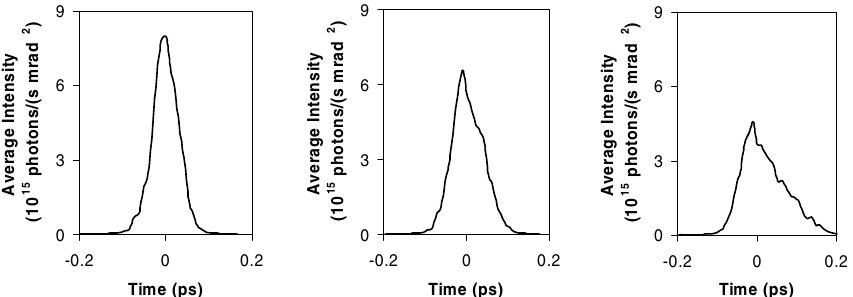
FIG. 15. Simulation of pulse slicing by Bragg reflection showing the spatially averaged intensity vs time for the case of radial collimation widths of 0.1 mrad (left panel), 0.25 mrad (middle panel), and 0.5 mrad (right panel), corresponding to FWHM pulse durations of 70, 80, and 100 fs, respectively, and total photon counts of 19, 113, and